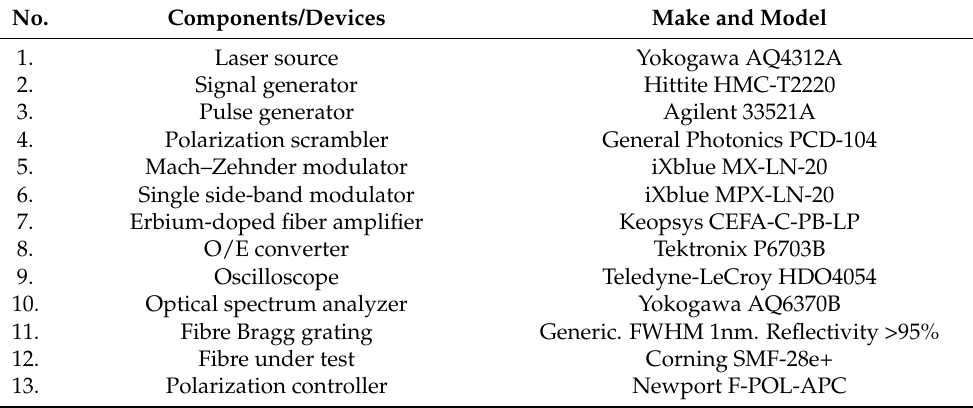
Table 1. List of components and equipment used in the